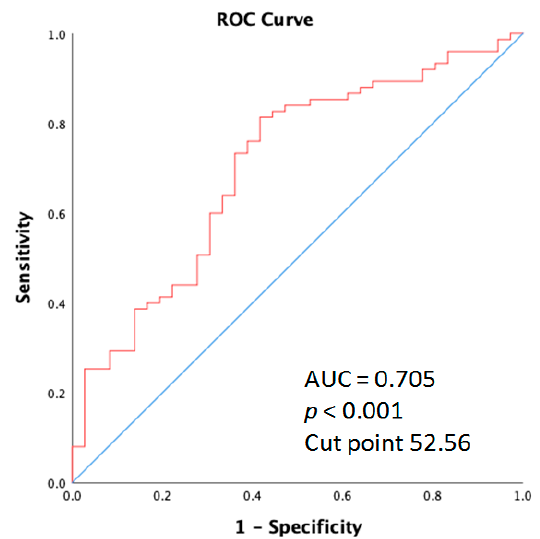
Figure 5. Receiver operation characteristic (ROC) curve analysis of the age for acne in metastatic colorectal cancer patients who received anti-EGFR inhibitor therapy.